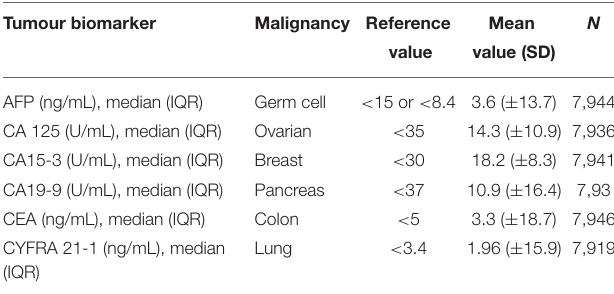
TABLE 2 | Reference values of measured tumour biomarkers and their values in PREVEND population. Tumour biomarker Malignancy